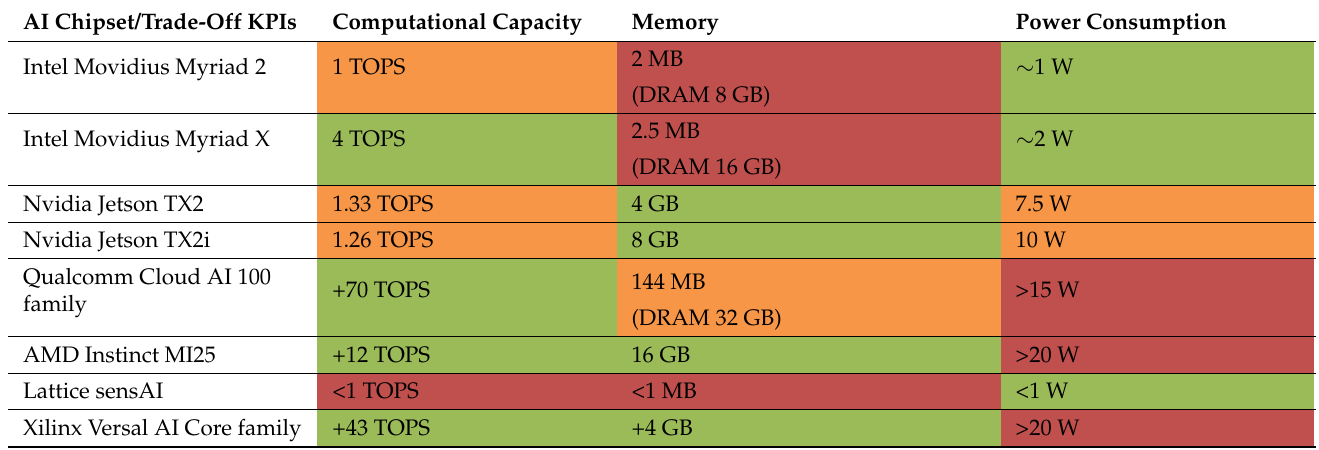
Table 7. Trade-off of the AI chipsets under